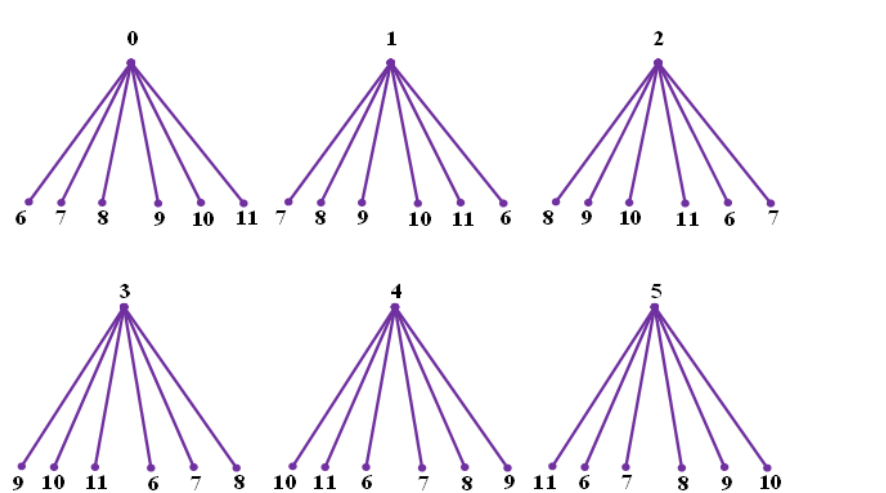
Figure 3. An edge decomposition of 𝐶 8,4 by 𝐾 1,4 .